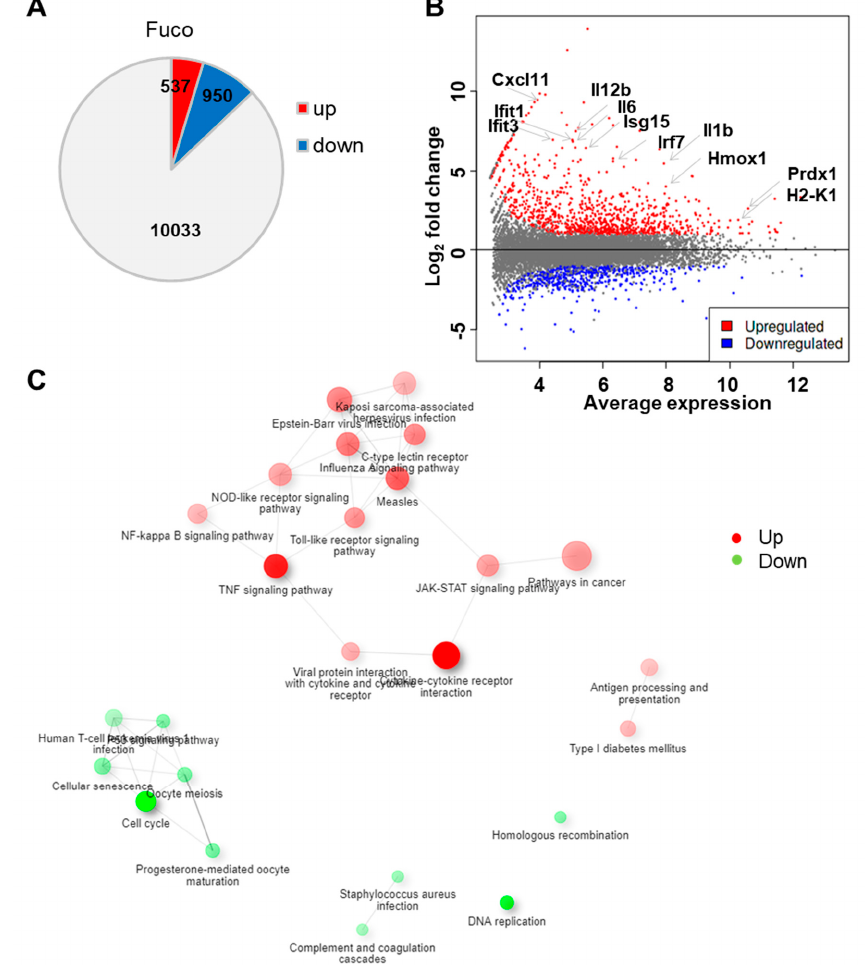
Figure 2. Fucoidan treatment upregulates genes related to immune response in BMDCs. ( A ) Number of differentially expressed genes in fucoidan-treated BMDCs relative to control-treated cells. ( B ) MA plot showing log fold-change and average gene expression in log count per million (cpm) in fucoidan-treated cells relative to control-treated cells. Representative upregulated genes are labeled with arrows. ( C ) Network visualization of overlaps among enriched KEGG pathways. Pathways are nodes and colored by the enrichment score, and edges are sized based on number of shared genes.